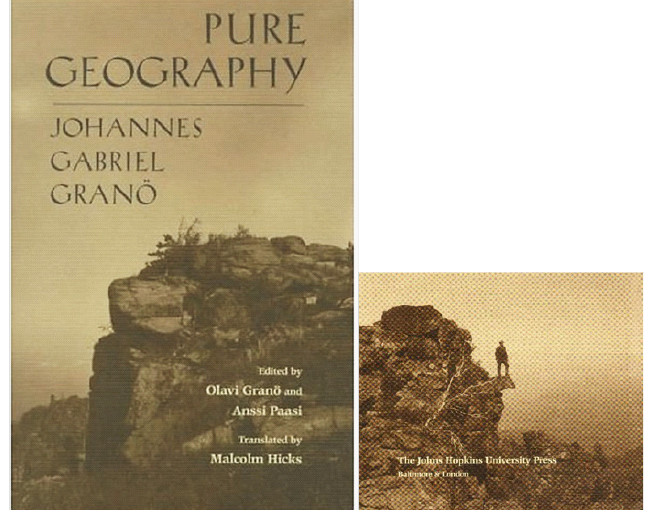
Figure 9: Front cover (left) and back cover of „Pure Geography“,